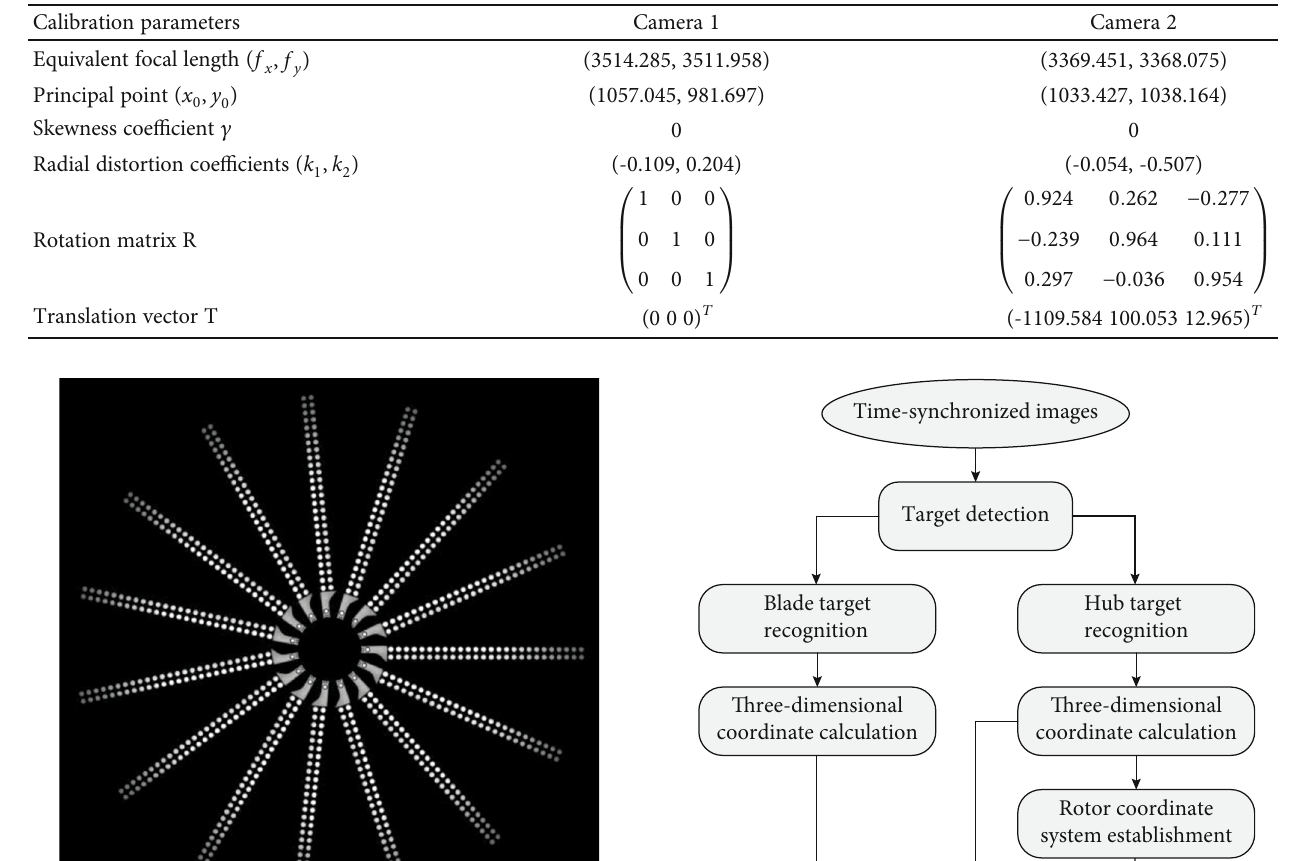
Table 1: Calibration results.